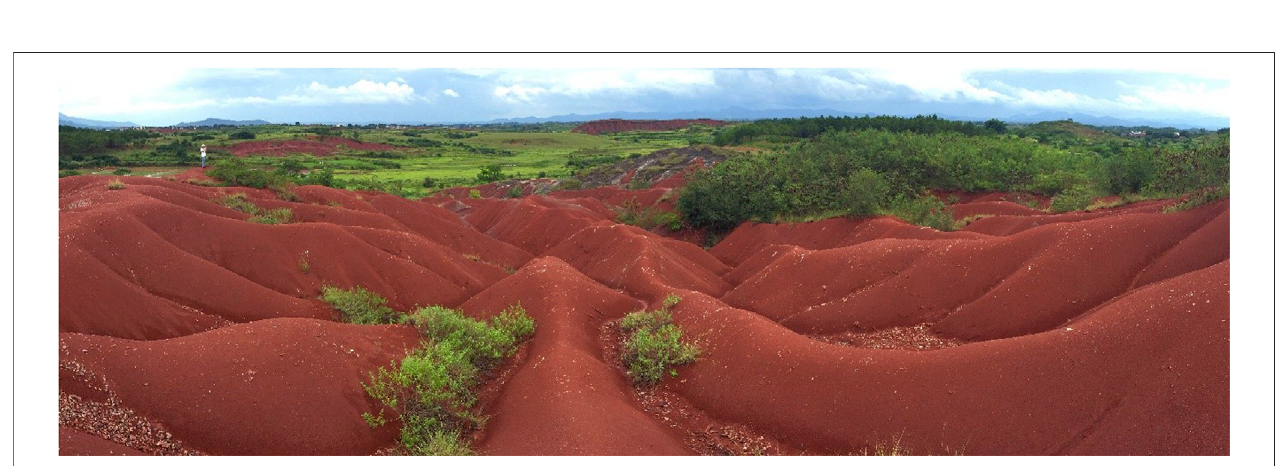
Frontiers in Earth Science |